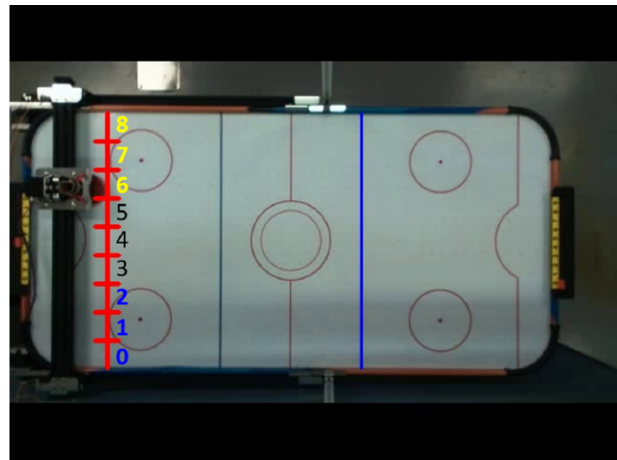
Figure 12. Schematic diagram of preliminary predicted moving area.